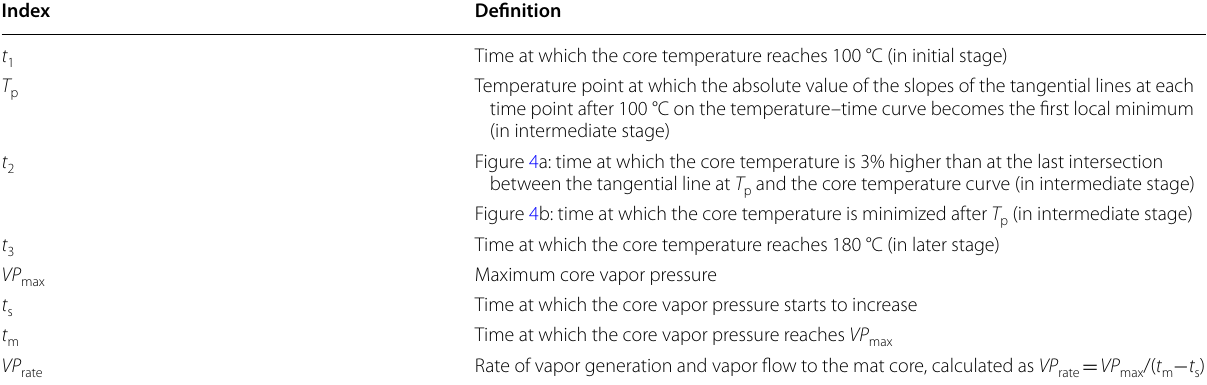
Table 3 Indices of the core temperature–time and vapor pressure–time curves Index